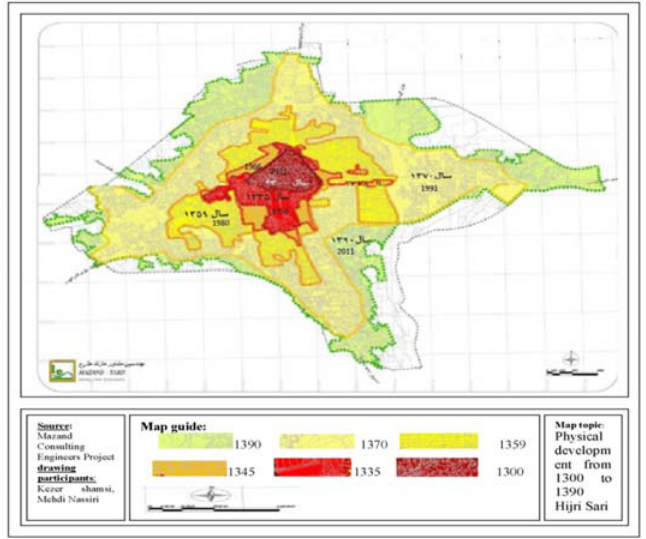
Fig. 2. Expansion of the city during the past half